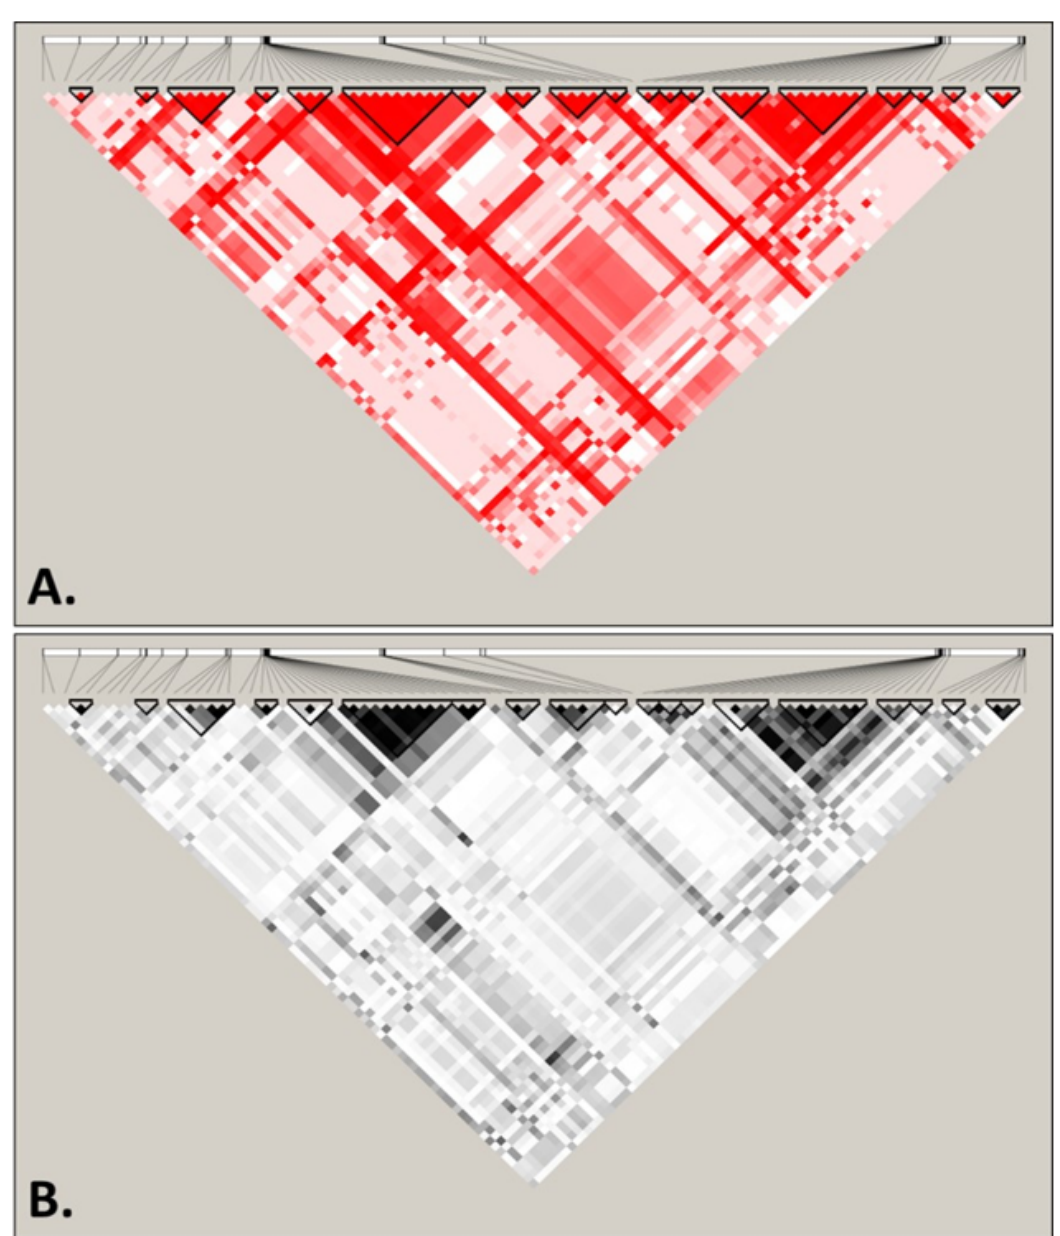
Figure 3. Patterns of linkage disequilibrium (LD) across the mtDNA genome of Saccharomyces cerevisiae displayed using D’ ( A ) and r 2 ( B ). Blocks of linkage disequilibrium are highlighted using black triangles. Analyses were performed considering 5475 bp across 6646 genomes.